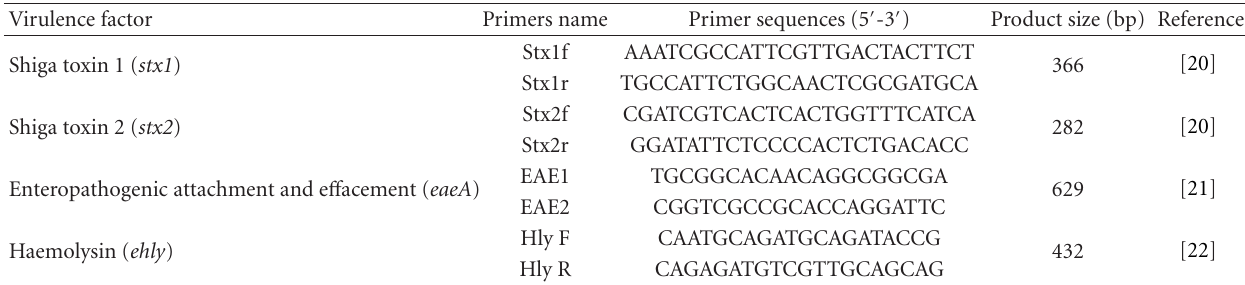
Table 1: Primers used for detection of virulence genes in Shiga toxin-producing Escherichia coli isolated from bovine mastitis .